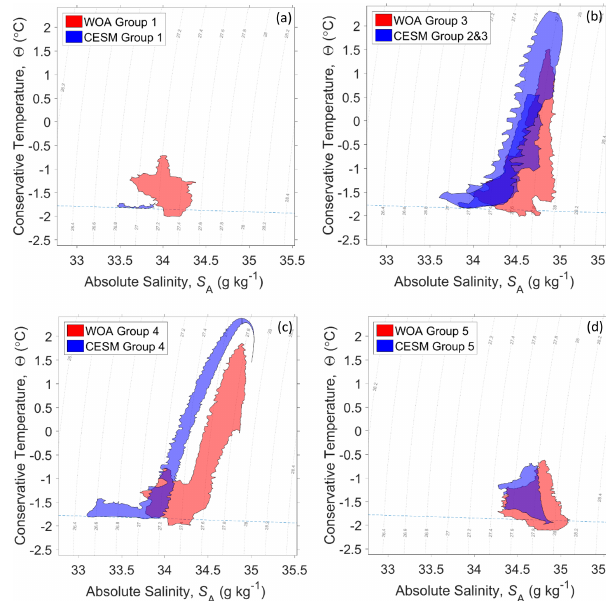
Figure 8. The core of water properties in WOA (red) and CESM2 (blue). Note that groups 2 and 3 have been combined for CESM2.